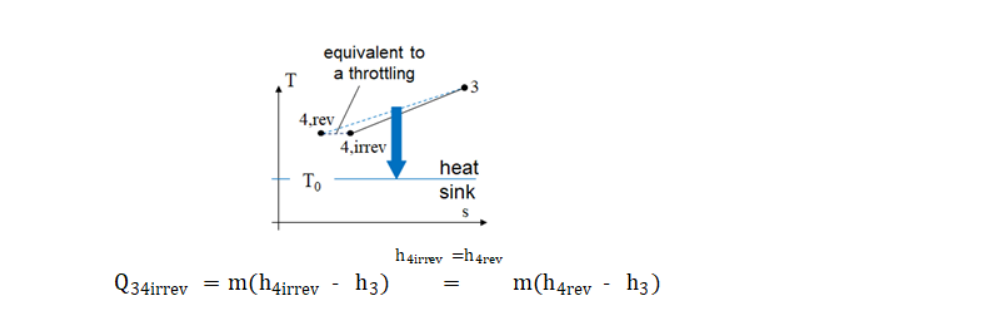
Figure 3. Irreversible heat input is equalizing the reversible one, constant pressure heating.